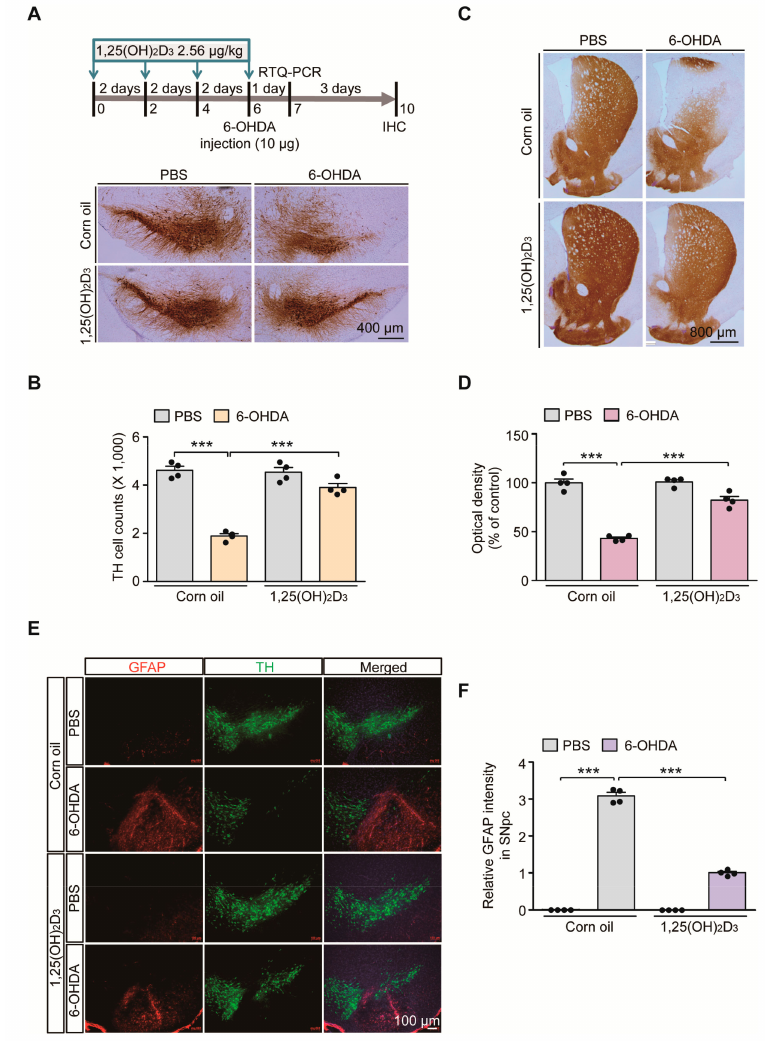
Figure 1. 1,25(OH) 2 D 3 treatment prevents dopaminergic loss and neuroinflammation in a 6-hydroxydopamine (6-OHDA) Parkinson’s disease (PD) mouse model. ( A ) Experimental schedule of 6-OHDA unilateral striatal injection to model PD in mice and 1,25(OH) 2 D 3 intraperitoneal administration (upper panel). 1,25(OH) 2 D 3 was administered once every two days (total four times) followed by stereotaxic 6-OHDA injection into the striatum of the right hemisphere. Total RNA from the ventral midbrain was prepared for RTQ-PCR application one day after the 6-OHDA striatal